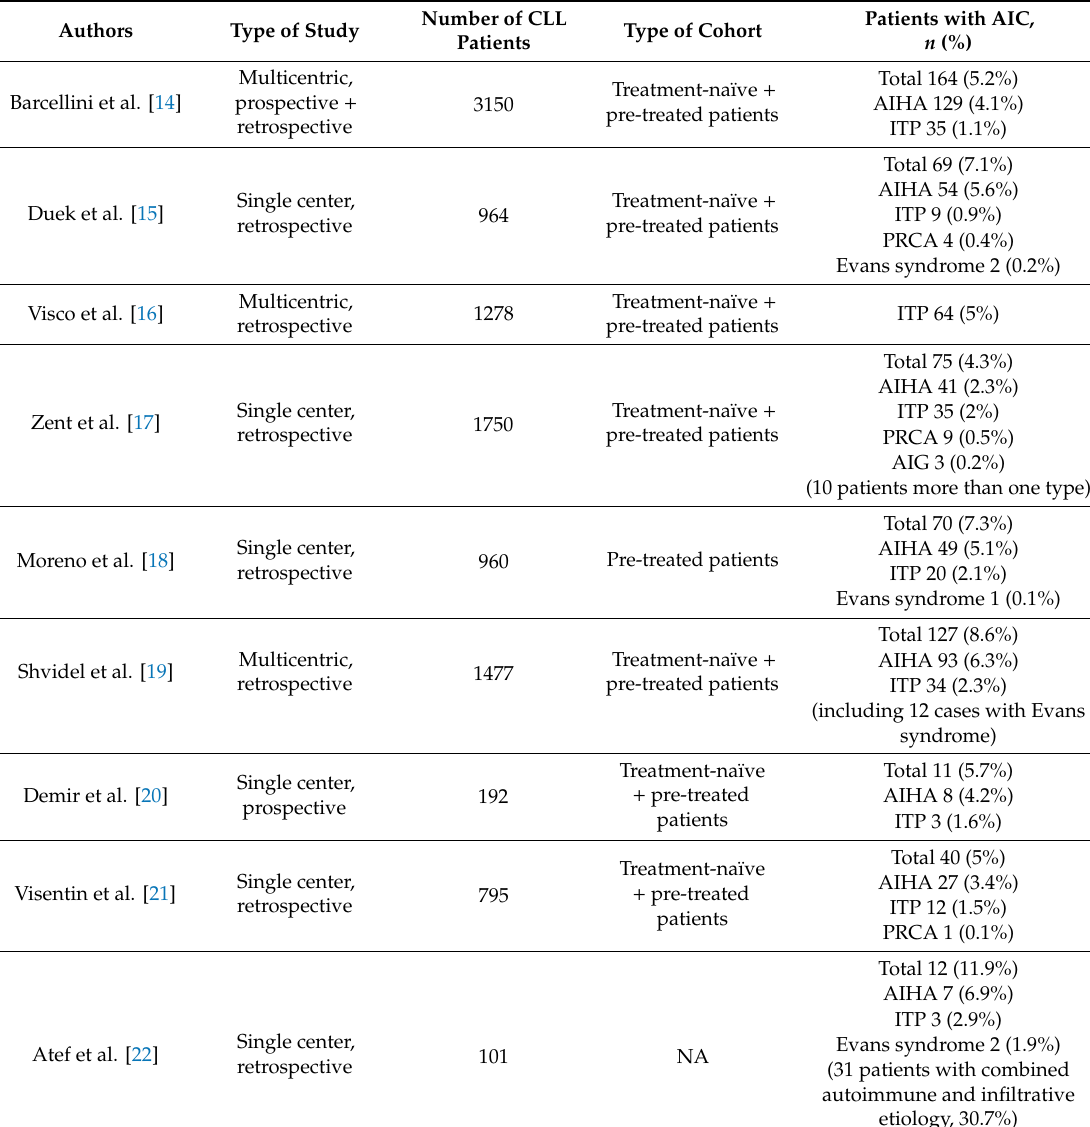
Table 1. Main studies describing the occurrence of autoimmune cytopenias in patients with